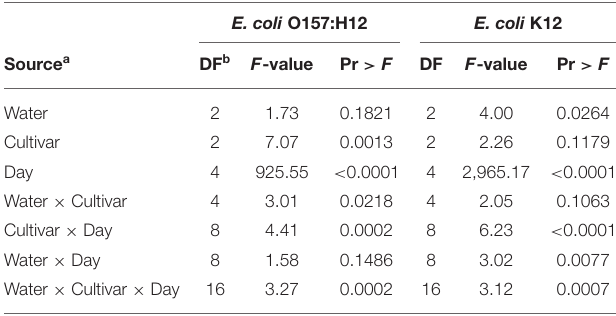
TABLE 1 | Analysis of variance (ANOVA) table for identifying the significant effects and their interactions with lettuce data on E. coli O157:H12 and Escherichia K12. E. coli